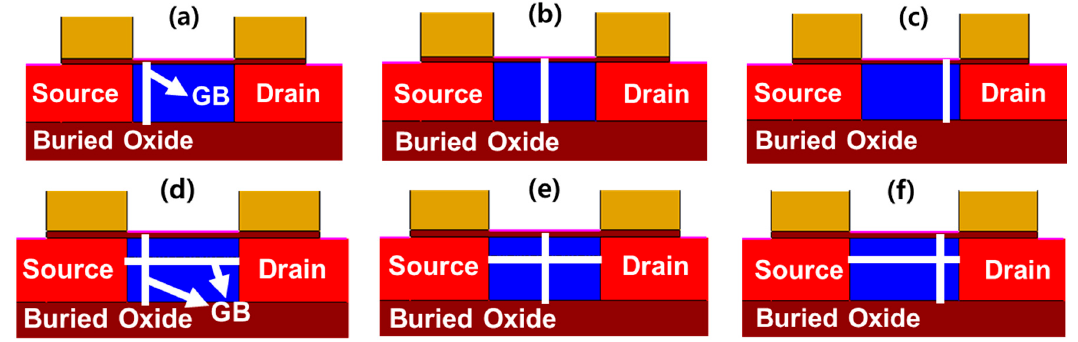
Figure 5. The simulated structure of poly ‐ Si 1T ‐ DRAM devices with different GB distributions. In ( a